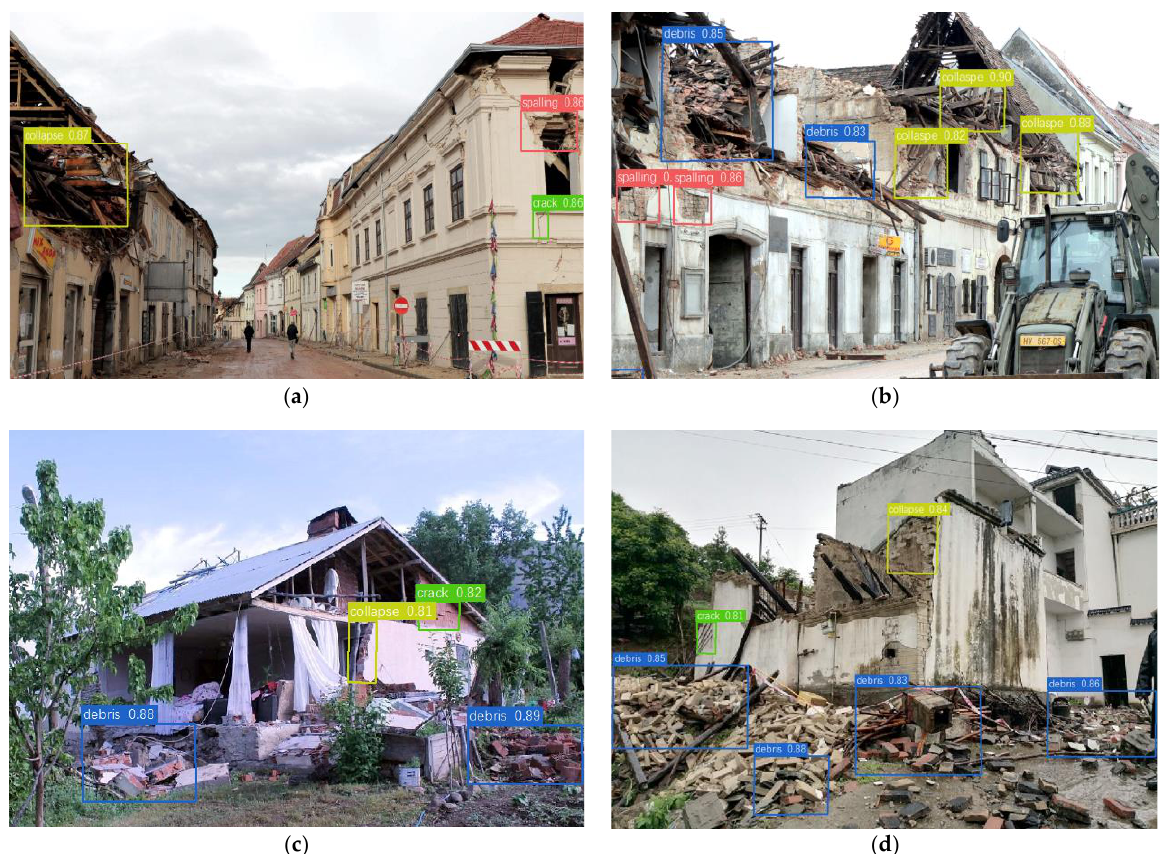
Table 5. Validation results of building damage using different datasets.